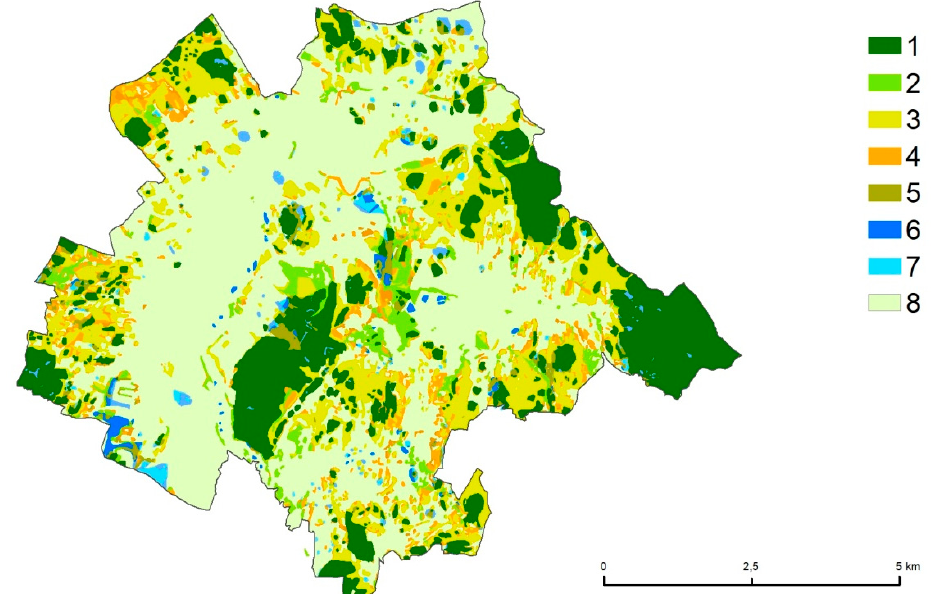
Figure 2. Distribution of forest cover change trajectory types: ( 1 ) Long-term stability, ( 2 ) single increase forest cover from grassland, ( 3 ) single increase forest cover from arable land, ( 4 ) dynamic increase forest cover from mixed agricultural land, ( 5 ) cyclical increasing forest cover, ( 6 ) single decrease forest cover into grassland, ( 7 ) dynamic decrease forest cover from mixed agricultural land, and ( 8 ) areas where the occurrence of forests has never been recorded during the investigated period.